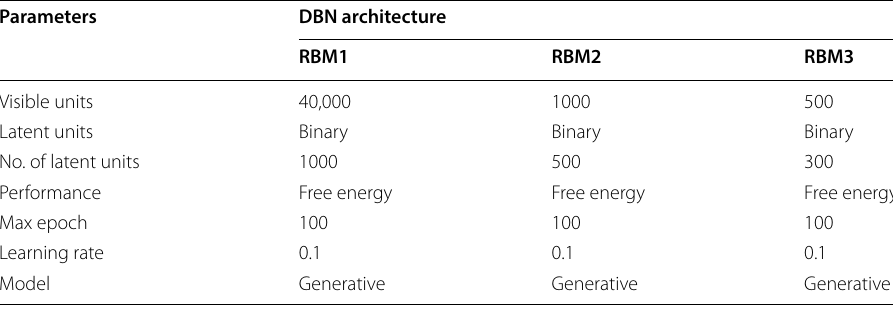
Table 1 Parameter setup for proposed